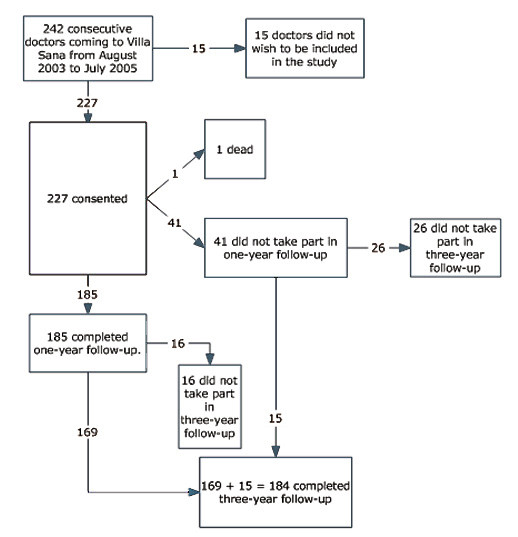
Flow chart over participation in the study.